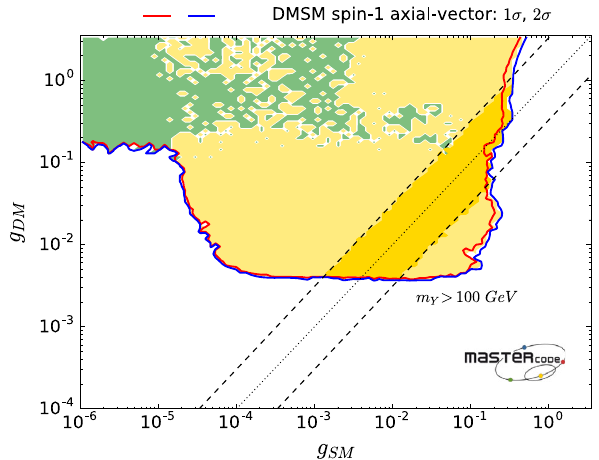
Fig. 10 Preferred regions in the ( g SM , g DM ) plane (on logarithmic scales)inthemodelwithaxial-vectorDMcouplings,againusingcolour coding to illustrate the dominant mechanisms bringing the DM density into the allowed range: green for annihilation via t -channel exchange into pairs of mediator particles Y that subsequently decay into SM par- ticles, and yellow for rapid annihilation directly into SM particles via the s -channel Y resonance. The diagonal dotted line indicates where g DM = g SM , and the band where 1 / 3 < g DM / g SM < 3 is bounded by dashed lines and shaded a darker yellow